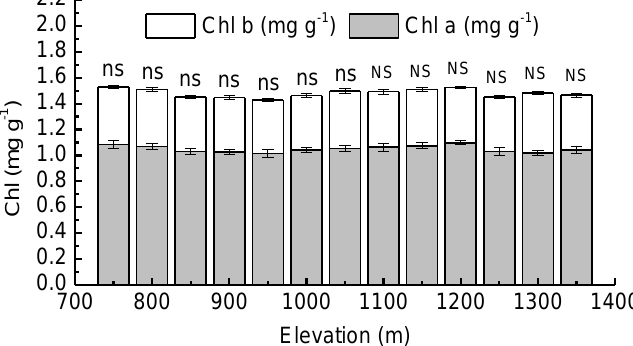
Figure 2. Mean values of chlorophyll a concentration (Chl a) and chlorophyll b concentration (Chl b) in needles of Pinus koraiensis at different elevations, Changbai Mountain. The abbreviations “ns” and “NS” mean not statistically significant in PBMF ( Pinus koraiensis and mixed broadleaved forests) and ECF (evergreen coniferous forests), respectively (both at the p < 0.05 level). For each elevation, the sample size was 5.